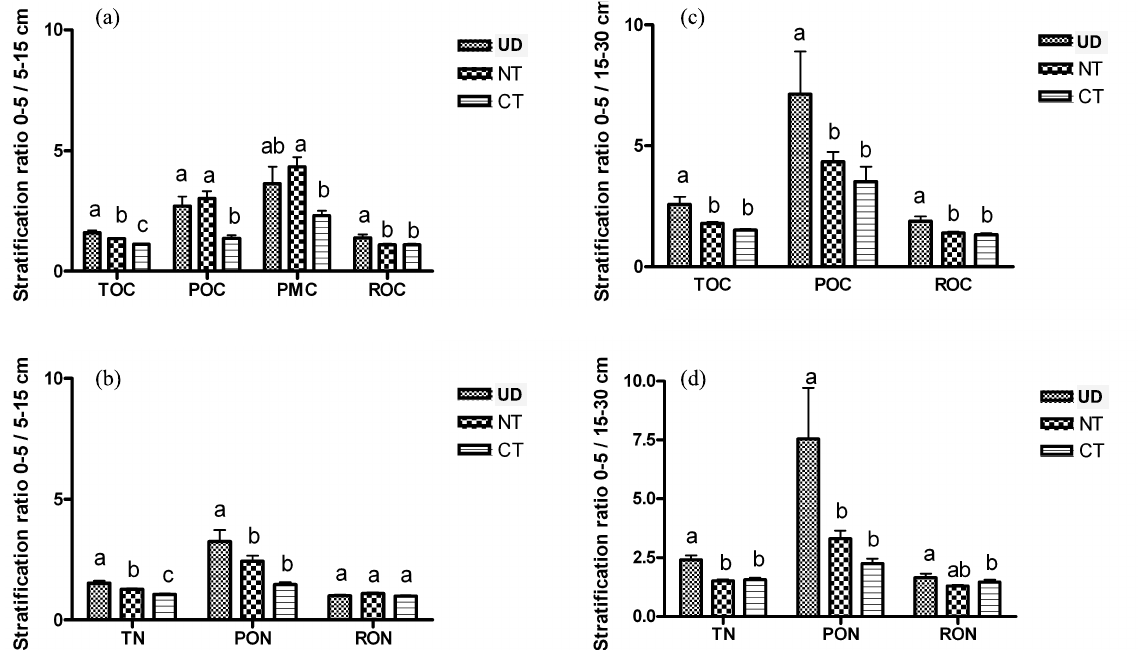
Figure 4. Stratification ratios for the layers 0–5/5–15 cm and 0–5/15–30 cm for (a & c) total organic carbon (TOC), particulate organic carbon (POC), potential mineralizable carbon (PMC, 0–5/5–15 cm only) and resistant organic carbon (ROC) and (b & d) total nitrogen (TN), particulate organic nitrogen (PON), resistant organic nitrogen (RON). Different letters indicate statistical differences among treatments. NT: untilled soils; CT: conventionally tilled soils; UD: undisturbed soils (Tukey test, p <